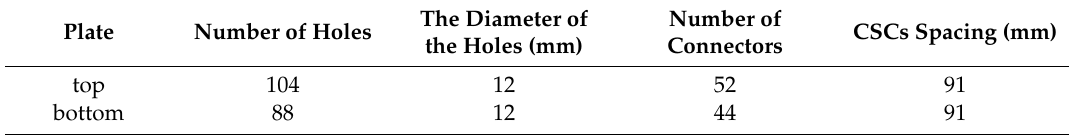
Table 7. The arrangement of holes and